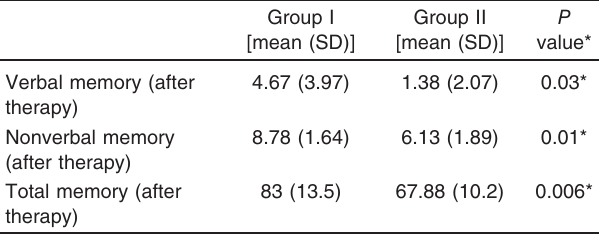
Table 4 Working memory results comparing the working memory group and the control group (after therapy)